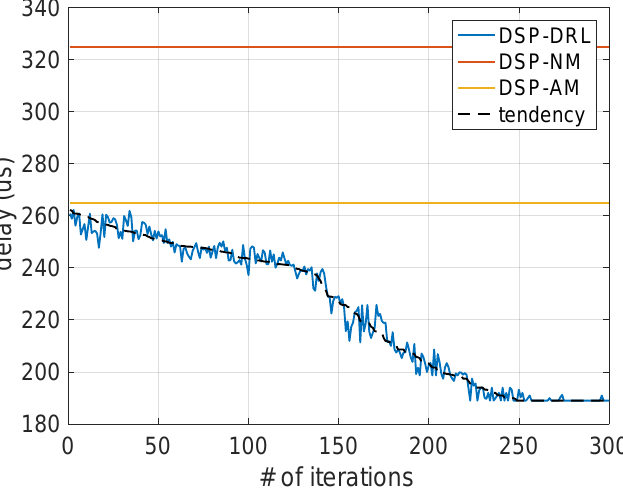
Figure 5. The convergence on total delay of 20